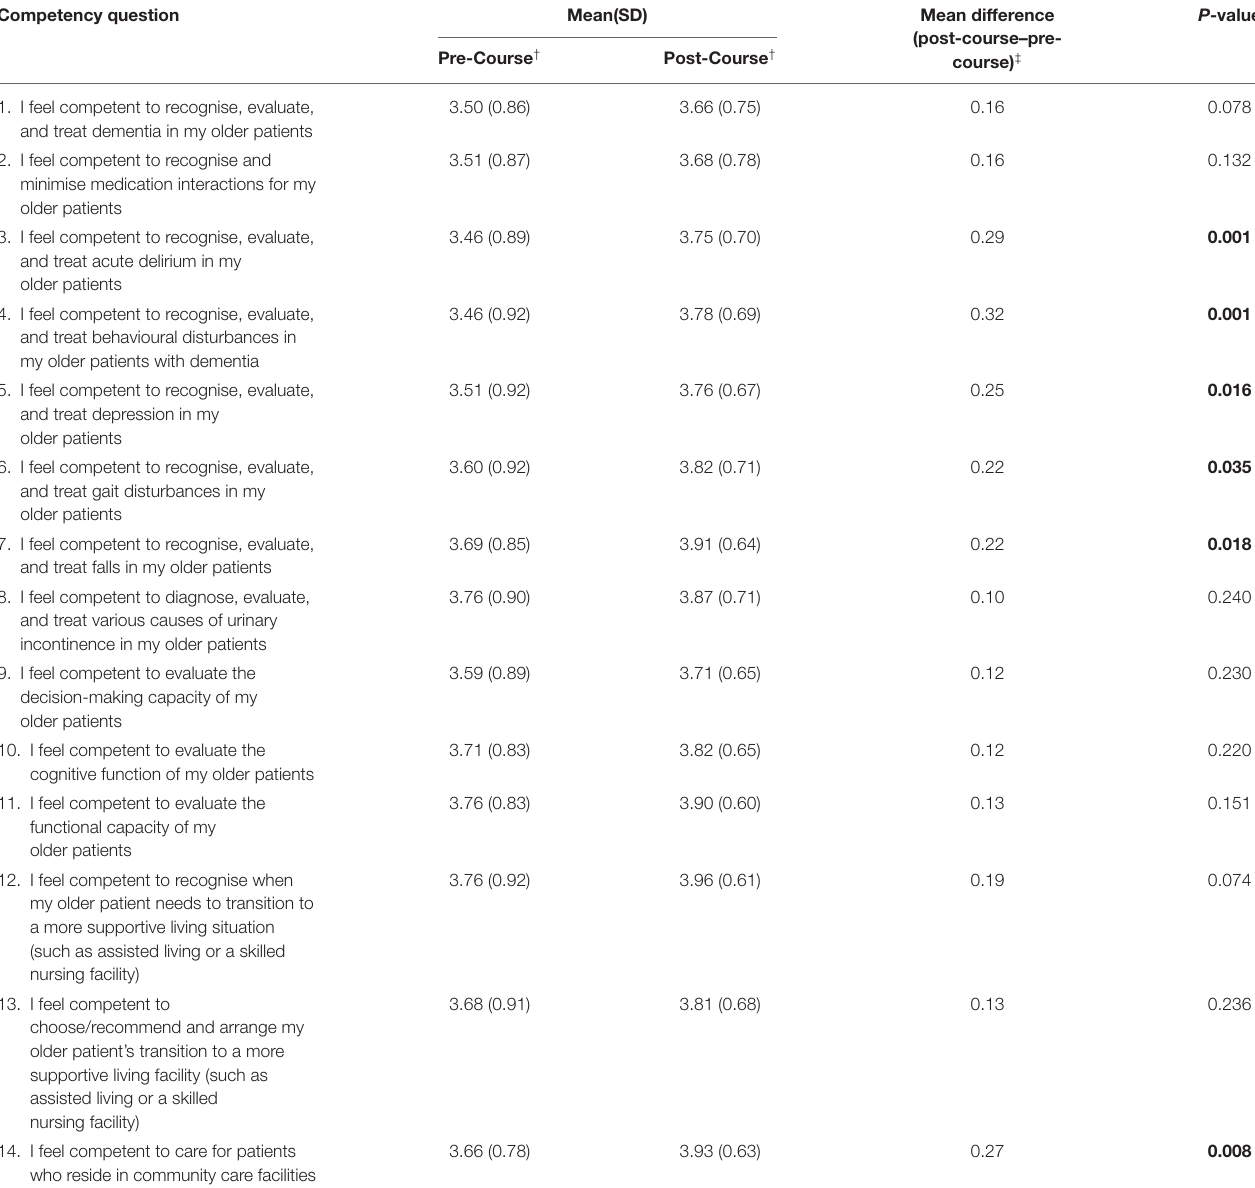
TABLE 2 | Students’ means, standard deviations, and P -value of self-perceived rating scores for each competency question. Competency question